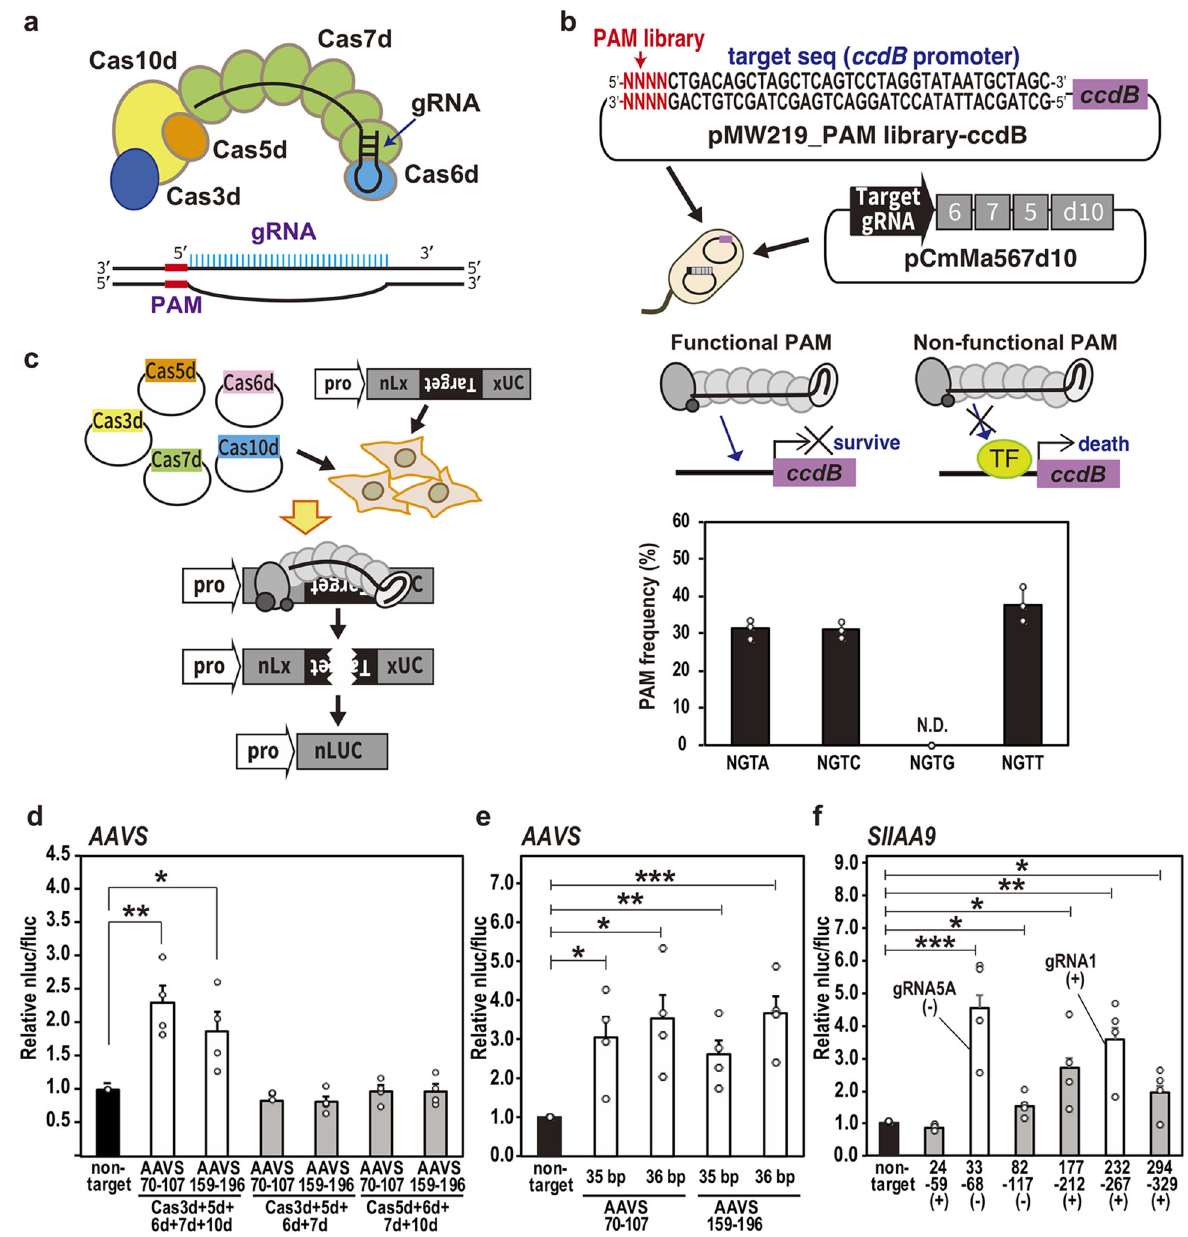
Fig. 1 Genome editing activity of CRISPR type I-D detected by luc reporter